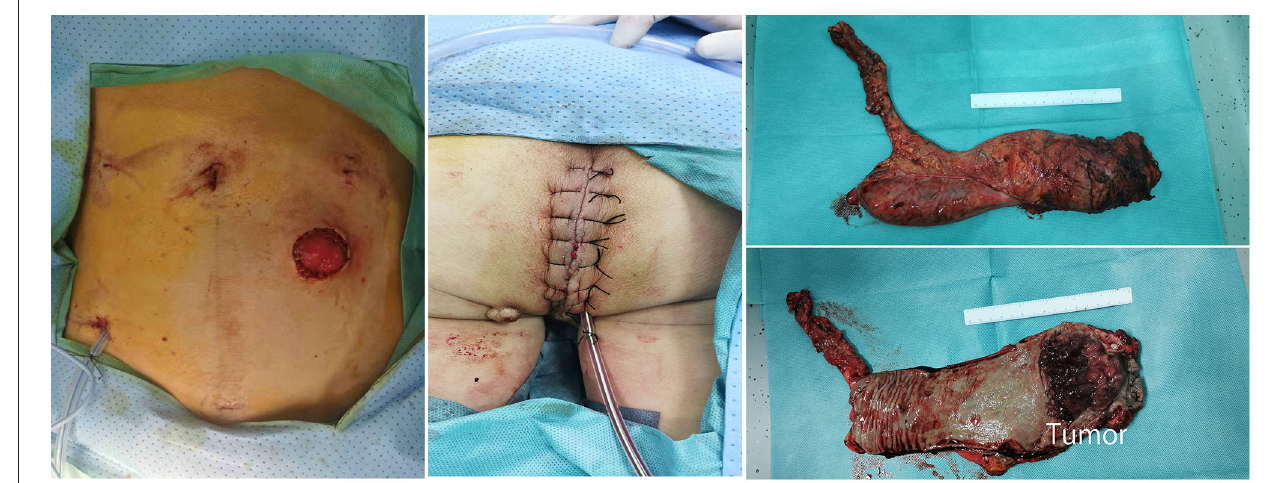
FIGURE 4 | Postoperative images of abdominal and perineal incision and specimen.